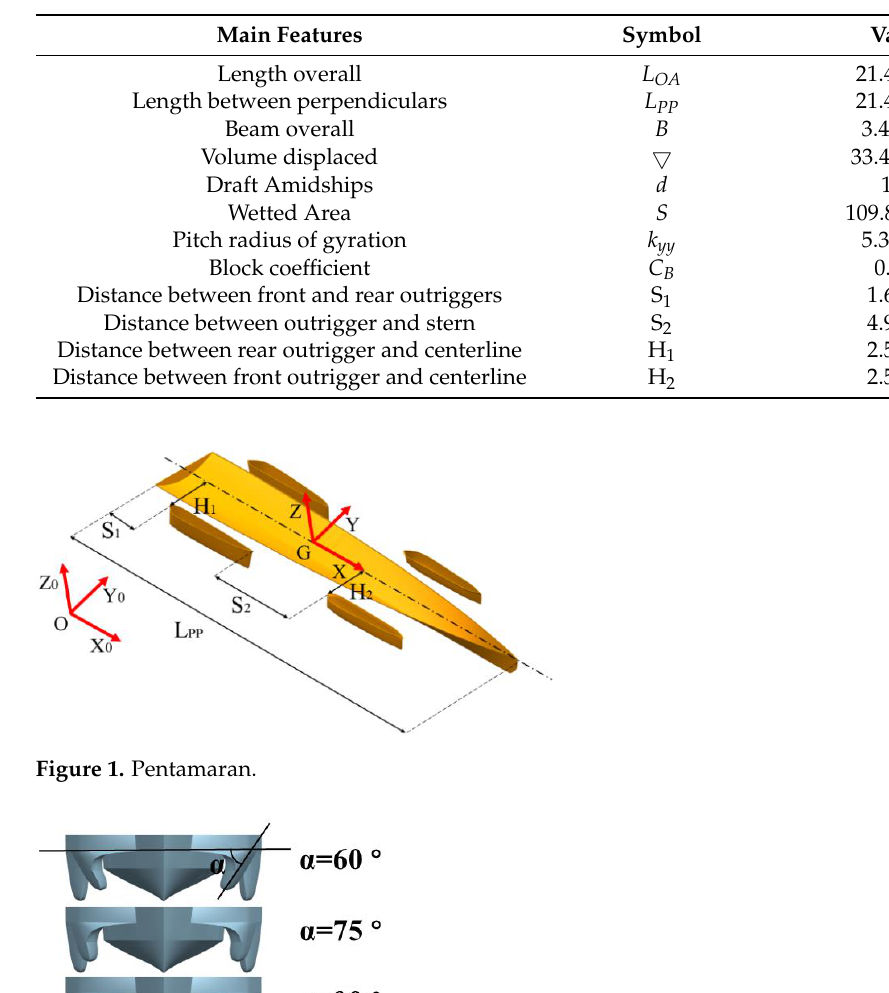
Table 1. Main dimensions of the pentamaran.